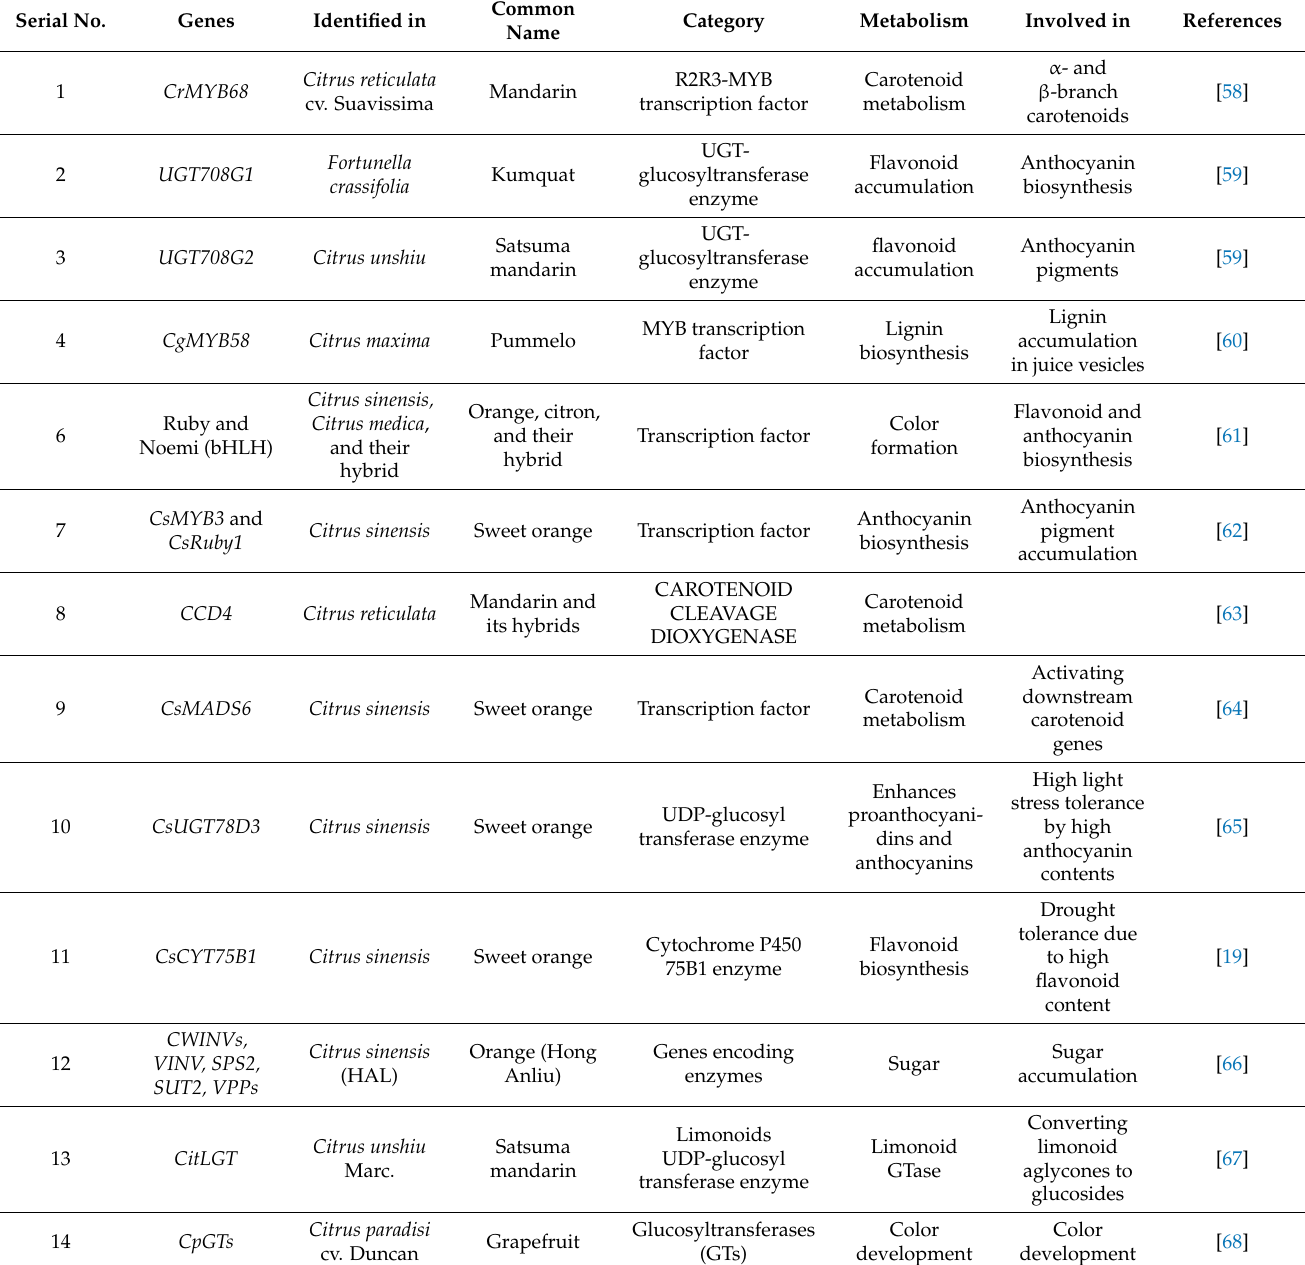
Table 2. Genes involved in the biosynthesis of different metabolites in Citrus species. Serial